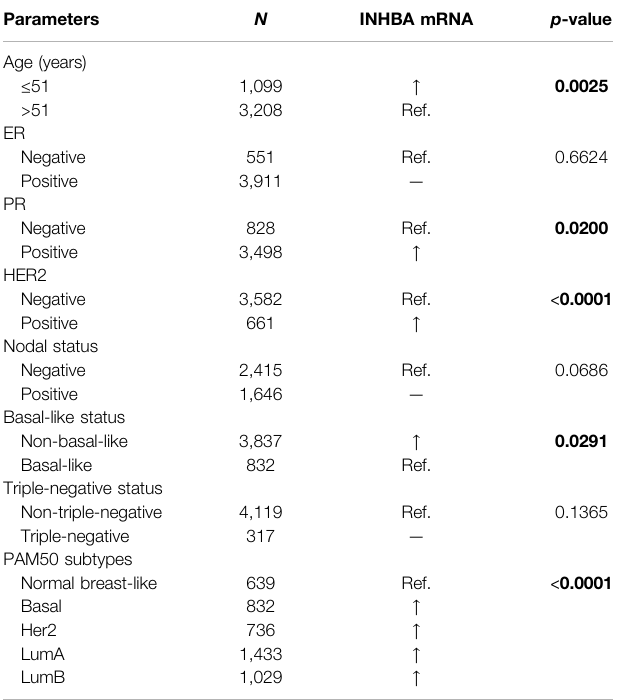
TABLE1| Correlation ofINHBAmRNAexpressionand clinicopathologicalfactors in breast cancer (bc-GenExMiner v4.7). Parameters N INHBA mRNA p